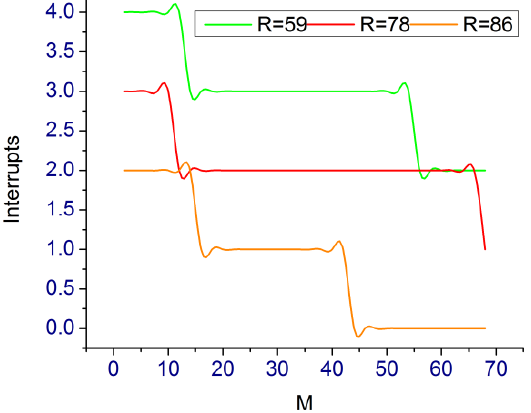
Figure 8. Interrupt Analysis.